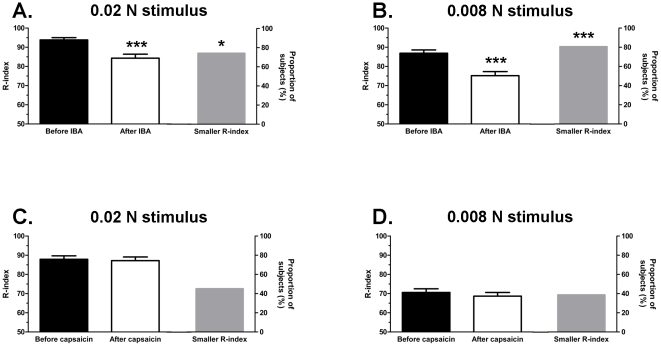
Effect of IBA and capsaicin on lingual tactile sensitivity.Each panel shows a pair of bar braphs. The left-hand pair plots the average R-index before (black bar) and immediately after (open bar) lingual IBA (or capsaicin) application. R-index is a derived measure of sensitivity ranging from 50–100%. A value of 50% represents the chance level of detection for a subject to distinguish between signal (tactile stimulus) and noise (no tactile stimulus) whereas a value of 100% indicates perfect discrimination. Error bars indicate SEM. * above open bar indicates significant differences in tactile sensitivity following lingual IBA (or capsaicin) administration. The grey bar to the right of each panel represents the proportion of subjects that had a smaller R-index (indicating worse detection) following lingual IBA (or capsaicin) administration. * above grey bar indicates a significant proportion of subjects had a smaller R-index following lingual IBA (or capsaicin). (A) Sensitivity to a 0.02N tactile stimulus was significantly reduced following lingual IBA (0.52%). (B) Sensitivity to a 0.008N tactile stimulus was significantly reduced following lingual IBA (0.52%) administration. (C) Sensitivity to a 0.02N tactile stimulus was not affected following lingual capsaicin (10 ppm) administration. (D) Sensitivity to a 0.008N tactile stimulus was not affected following lingual capsaicin (10 ppm).